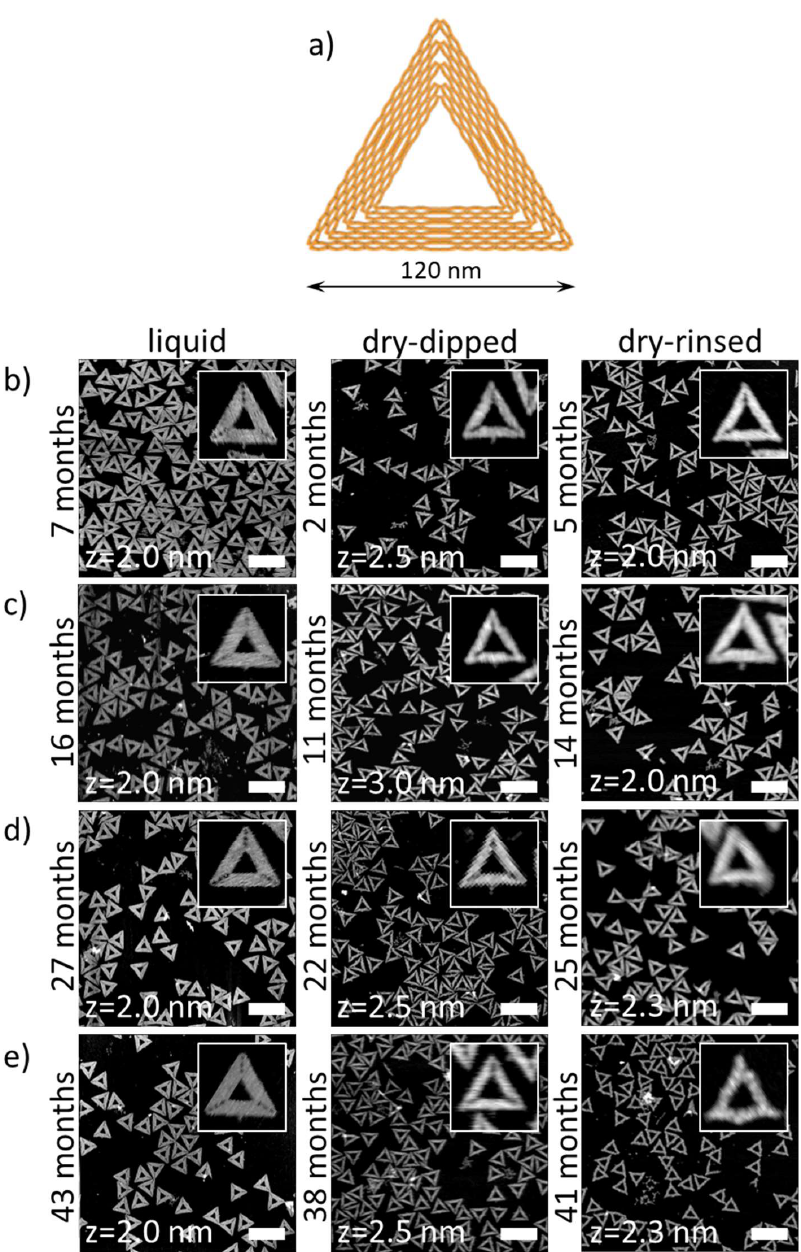
Figure 1. ( a ) Schematic illustration of the Rothemund triangle DNA origami. AFM images of DNA origami triangles assembled from staple sets aged for ( b ) 2–7 months, ( c ) 11–16 months, ( d ) 22–27 months, and ( e ) 38–43 months. Measurements were performed either in liquid (left column) or dry conditions after gently dipping the sample into water (central column) or after harsh rinsing (right column). Scale bars represent 250 nm. Height scales are given in the individual images. The insets show zooms of individual DNA origami triangles.